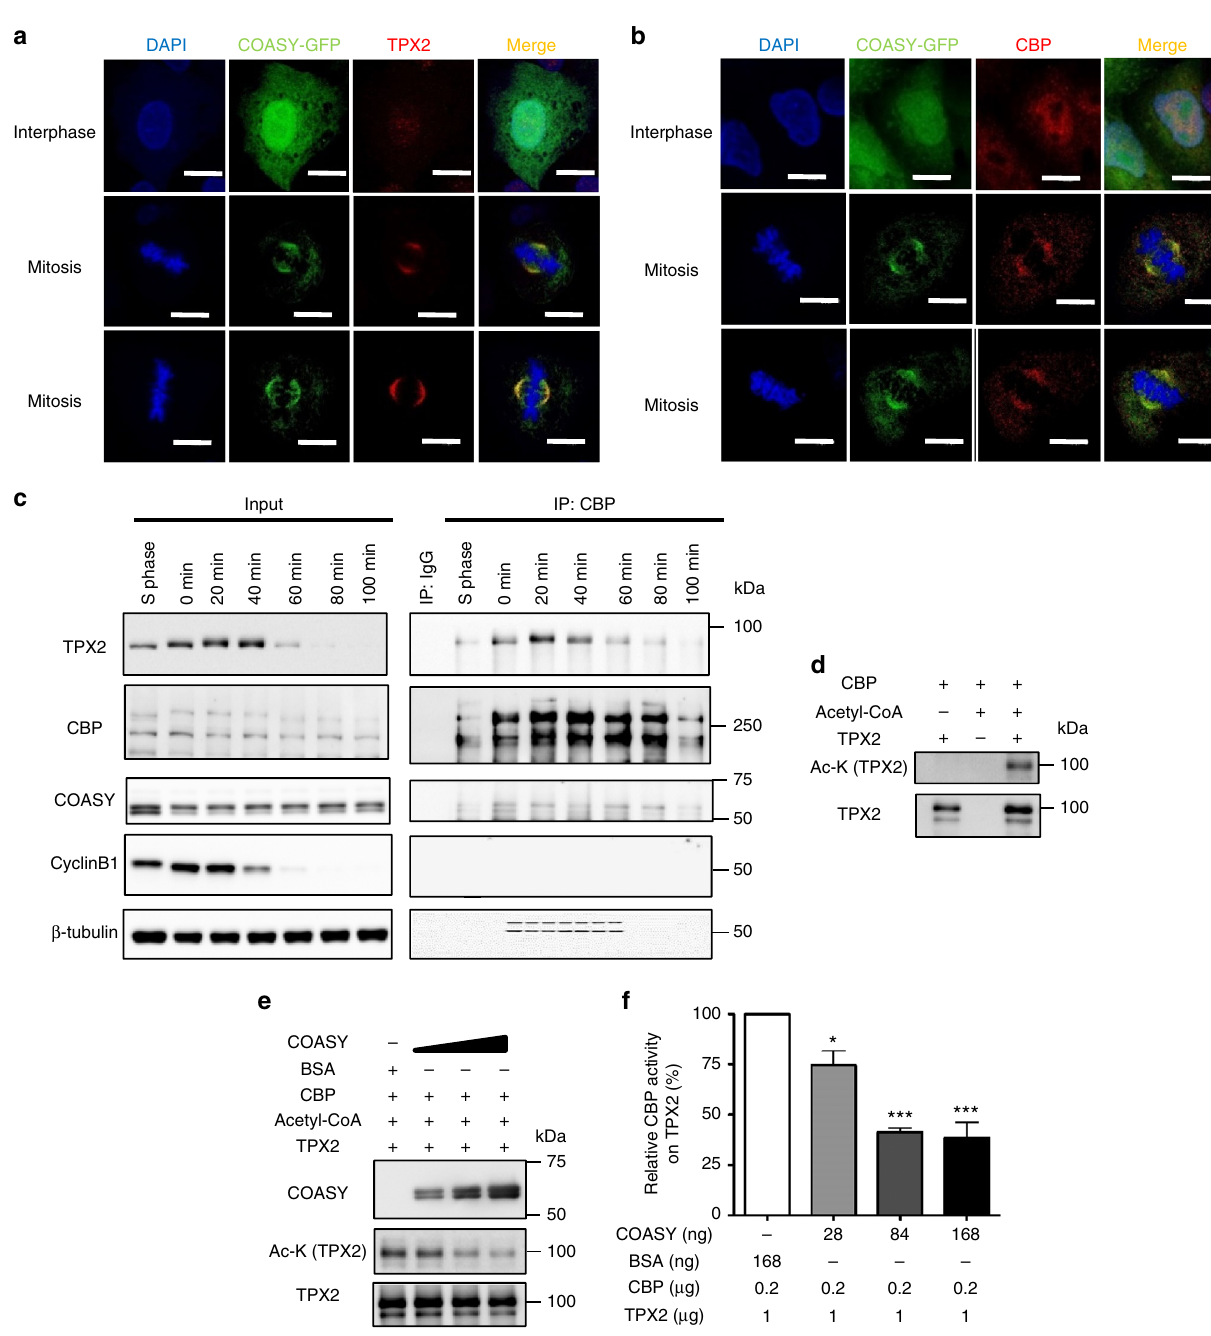
Fig. 5 Stage-speci fi c physical association and in vitro CBP activity assays suggest direct interaction among COASY, CBP, and TPX2. a TPX2 and b CBP showed colocalization with COASY in spindle microtubules during mitosis. COASY-GFP expressing A549 cells were stained with TPX2 ( a ) or CBP ( b ) antibody for confocal microscopy. Scale bars, 10 mm. c TPX2 and COASY physically associate with CBP during mitosis. A549 cells were synchronized